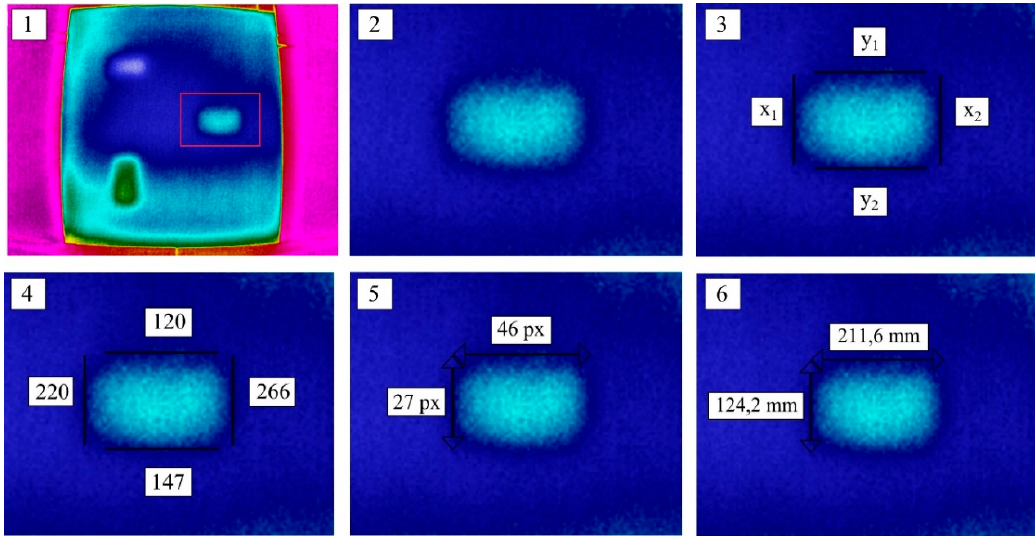
Figure 21. Procedure for estimating the defect size on the basis of the known size of a single pixel (4.6 mm).